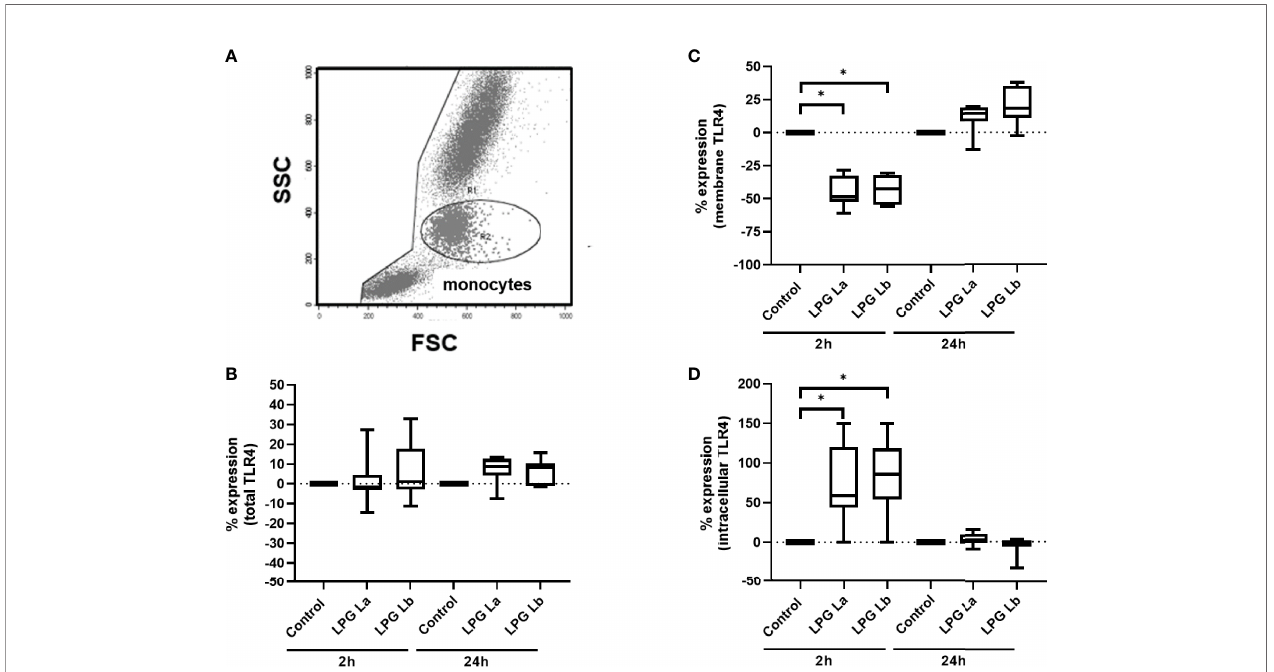
FIGURE 4 | Lipophosphoglycans from Leishmania spp. induces TLR4 internalization. PBMCs (5 x 10 5 cells/200 m L) were incubated in the presence of LPG (10 m g/mL) from L. amazonensis (La) or L. braziliensis (Lb) for 2 h or 24 h of incubation. The cells were fi xed and TLR4 expression was assessed by fl ow cytometry, de fi ning the monocyte population by FSC-H x SSC-H. Results are shown as percent of TLR4 immuno fl uorescence intensity (MFI) in LPG-treated cells relative to MFI of control cells incubated in the absence of LPG. (A) Gate for the population of interest. (B) Total TLR4 expression (membrane + intracellular) after 2 h or 24 h (C) TLR4 membrane expression after 2 h or 24 h incubation. (D) Intracellular TLR4 expression (total minus membrane) after 2 h or 24 h of incubation. Data represent medians, interquartiles, and minimum and maximum values (n = 4 donors, evaluated in two independent experiments). *p < 0.05 (vs. control), by Anova Kruskal- Wallis followed by Dunn ’ s post hoc